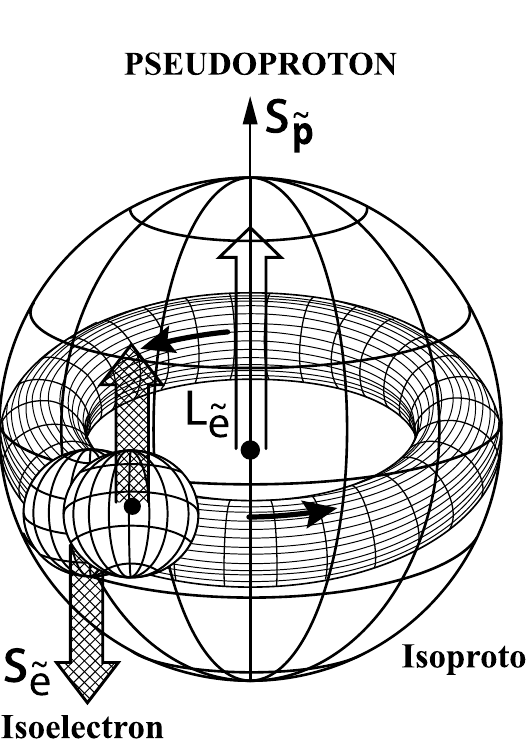
Figure 14: A conceptual rendering of the pseudo-proton created by the “compression” of an electron, this time, inside a neutron, or equivalently, of a valence electron pair in singlet coupling, resulting in a negatively charged hadron with spin 1 .